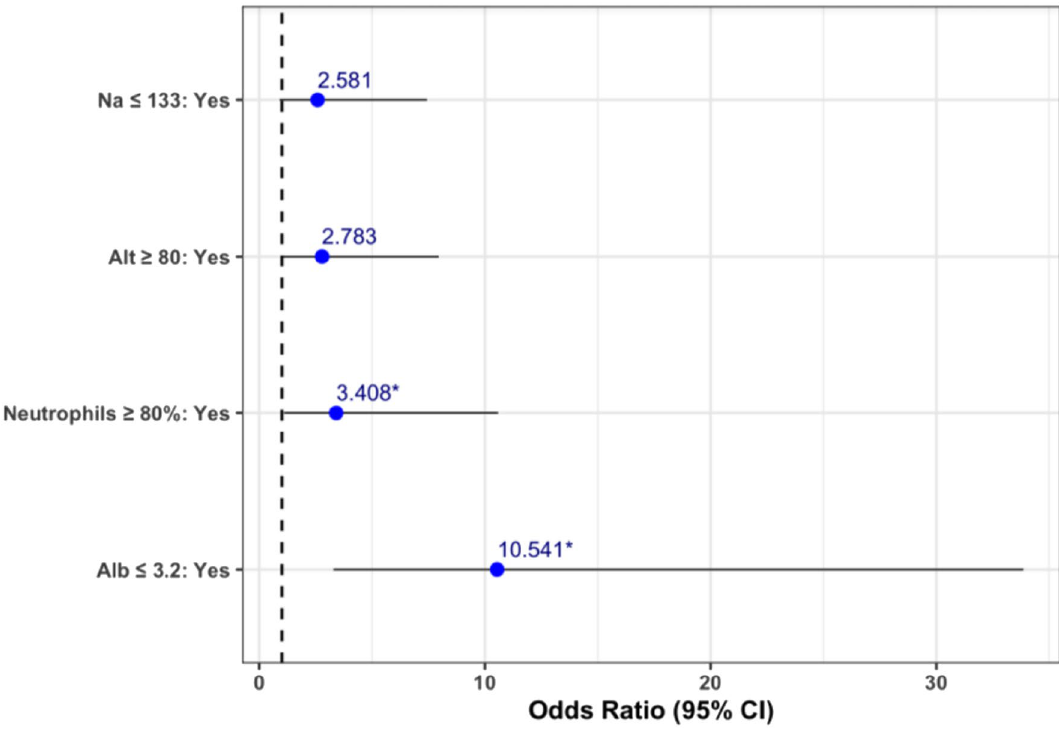
Figure 2. Multivariable logistic regression analysis of factors associated with IVIG non-response.